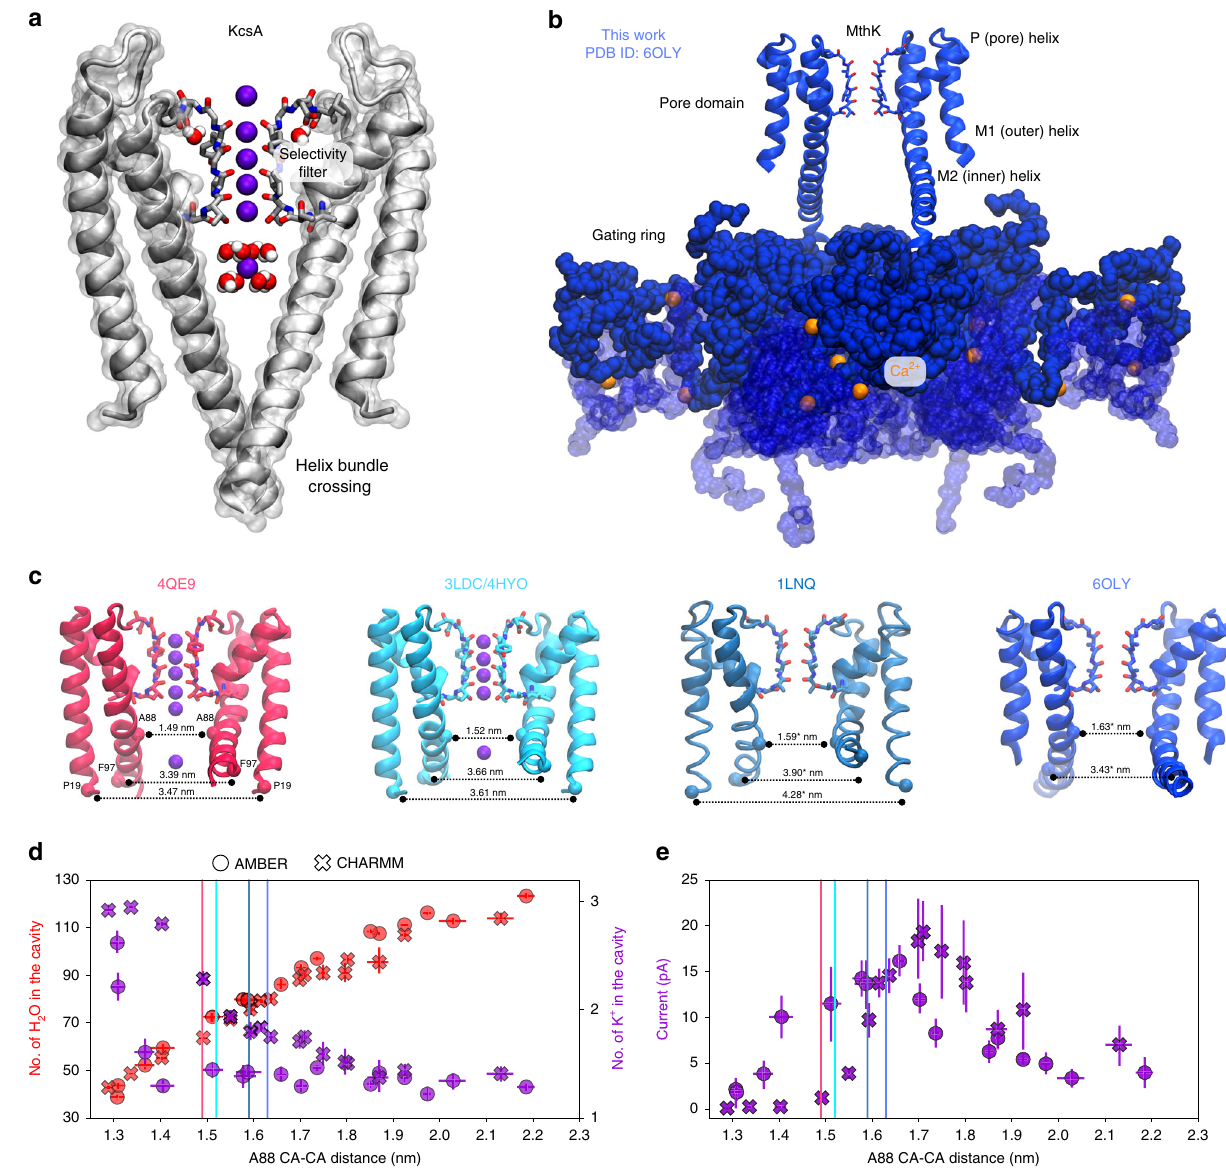
Fig. 1 An overview of potassium channel gating. a Crystal structure of KcsA in a closed state (PDB ID: 1K4C), showing the helix bundle crossing of the AG and the SF in the conductive state (two diagonally opposite monomers are shown for clarity). b Crystal structure of a full-length MthK channel in an open conformation. The pore (transmembrane (TM)) domain is linked to the cytoplasmic domains termed gating ring (shown in blue surface), which bind Ca 2 + ions (orange spheres). The conformational changes of the gating ring pull M2 helices from the pore domain, which underlies gating transitions. c Crystal structures of MthK showing different levels of TM helices opening. The cross distances between CA atoms of residues P19, F97, and A88 between diagonally opposite monomers of a channel tetramer are shown (* indicates that the monomers are placed asymmetrically in the crystal structure; in this case, the average distance is shown). In all structures, the SF is modeled in the conductive state. d Number of water molecules and potassium ions in the cavity observed in MD simulations of MthK, as a function of channel opening (A88 CA – CA distance, see c ). Opening levels observed in crystal structures are shown as vertical lines. e Outward K + current through MthK at 300 mV as a function of AG opening. Error bars represent 95% con fi dence intervals. Source data are available as a Source Data fi